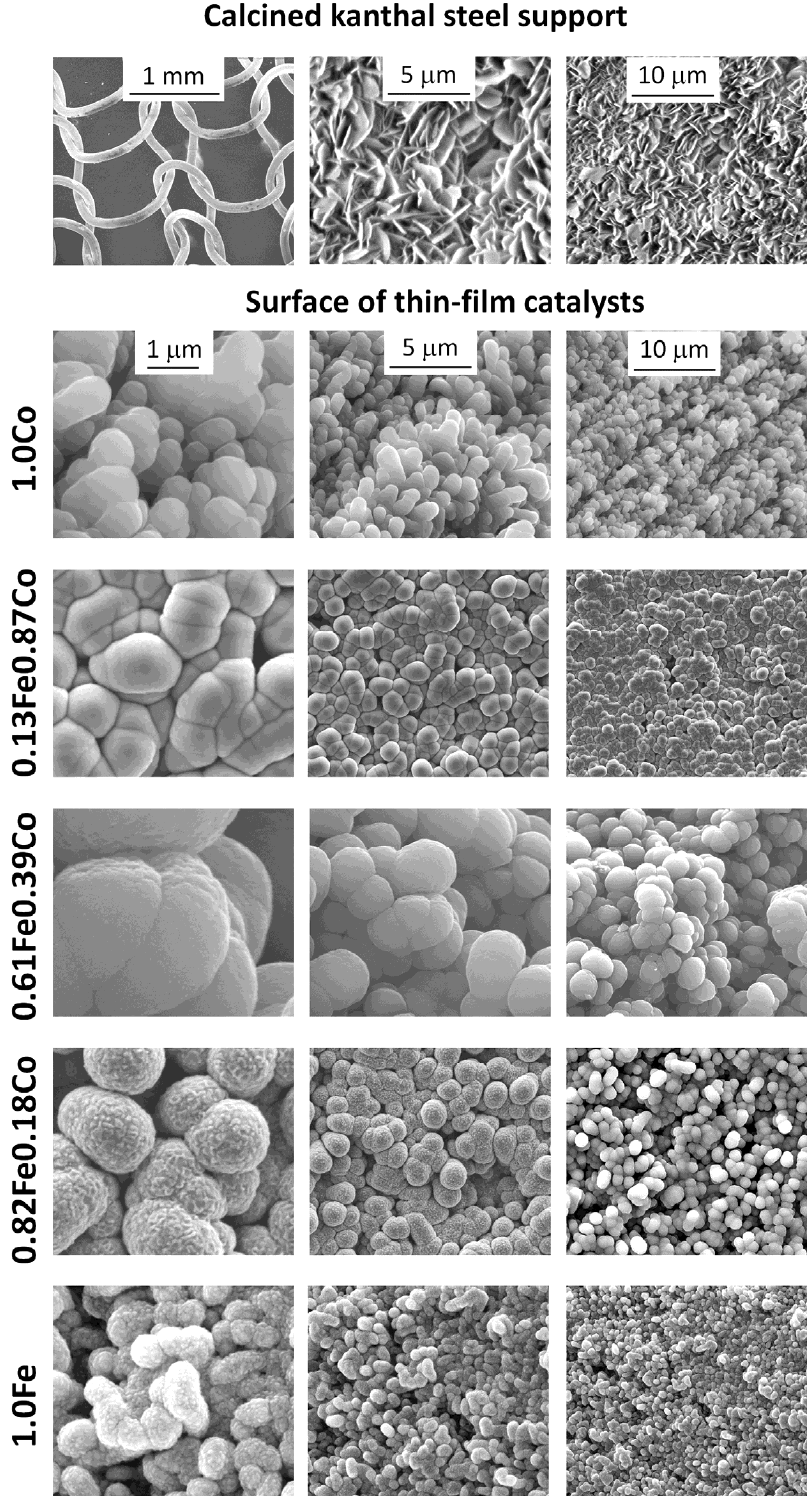
Figure 2. SEM images of the surface of the calcined wire-mesh support and different thin-film catalysts with the increasing fraction of iron.